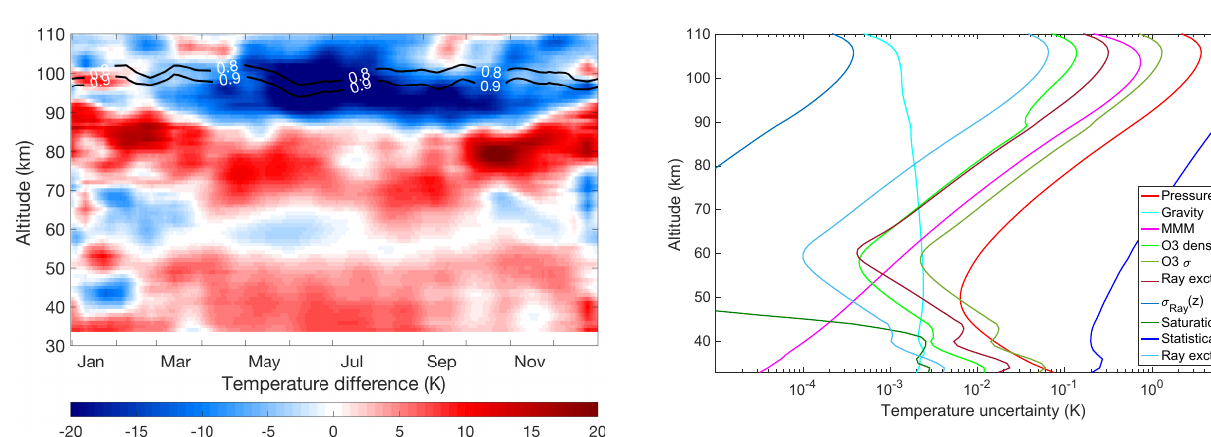
Figure 3. Temperature difference between the calculated climatol- ogy from monthly CIRA-86 temperature profiles and the OEM PCL temperature climatology (CIRA-86 minus OEM PCL). The black lines are the height below which the temperature climatology is more than 90% (0.9) and 80% (0.8) due to the measurements.